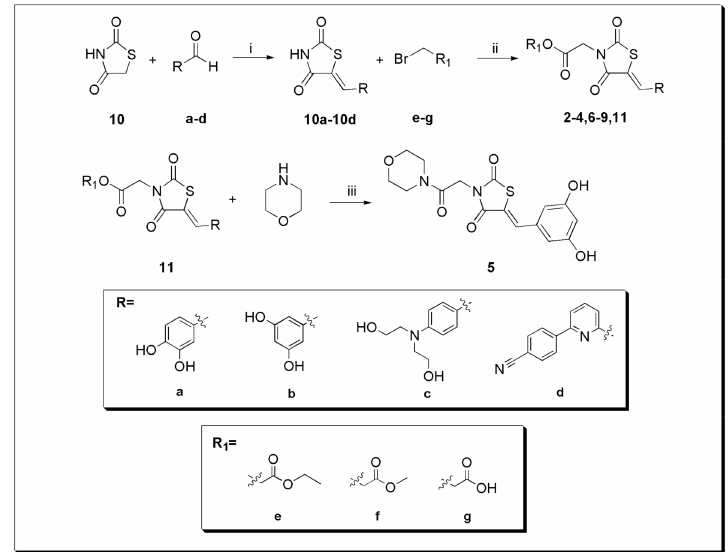
Scheme 1. Synthetic strategy for compound 2 – 9 . Reagents and conditions: (i) piperidine, EtOH, reflux 16–24 h; (ii) NaH, DMF dry, 80 ◦ C 16–20 h; (iii) HOBt, DIC, DMF, r.t. overnight.